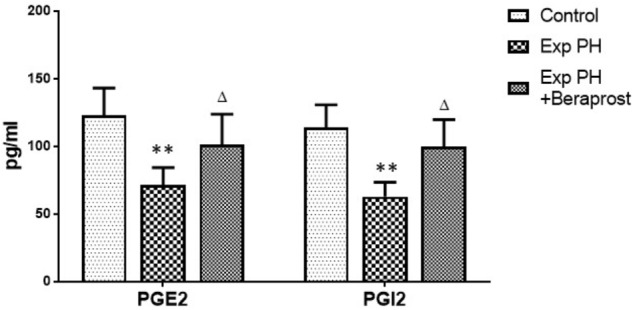
PGI2 and PGE2 levels in Plasma in control (n = 12) and experimental PH rats untreated (n = 24) and after 21 days Beraprost treatment (n = 12). PGI2 and PGE2 were measured by ELISA. Results are mean ± SEM. ∗∗p < 0.01 Exp PH vs. control group. ∆p < 0.05 Exp PH vs. Exp PH + Beraprost group.